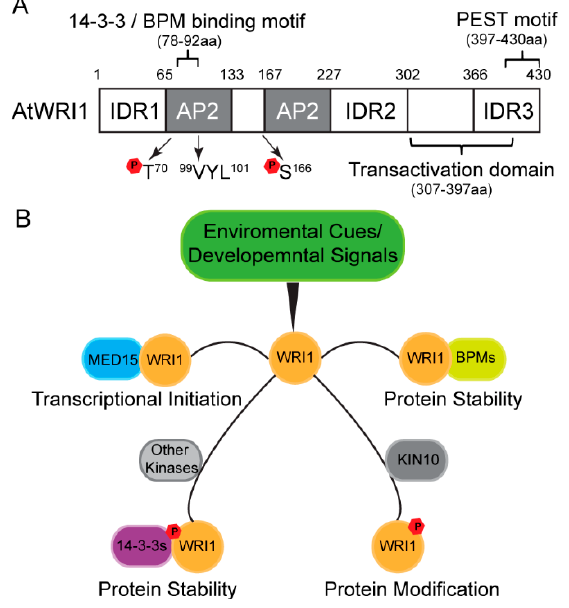
Figure 1. Arabidopsis WRINKLED1 (AtWRI1) structural features and regulatory mechanism of AtWRI1-mediated oil biosynthesis. ( A ) Schematic diagram of domains and motifs of AtWRI1, including two APETALA2 (AP2) domains, three intrinsically disordered regions (IDRs), a functional motif of “VYL”, the transactivation domain (TAD), the binding motifs of 14-3-3 and E3 ligase adaptor (BPM), PEST degradation signal sequence, and the KIN10 phosphorylation sites. ( B ) Post-translational regulatory mechanisms for AtWRI1 mediated by phosphorylation and newly identified interacting regulators, including Mediator Subunit 15 (MED15), BPMs, and kinase KIN10. The regulators modulate the protein stability and transcriptional activity of AtWRI1 via interactions and modifications, which in turn alters the gene expression of AtWRI1 targets.